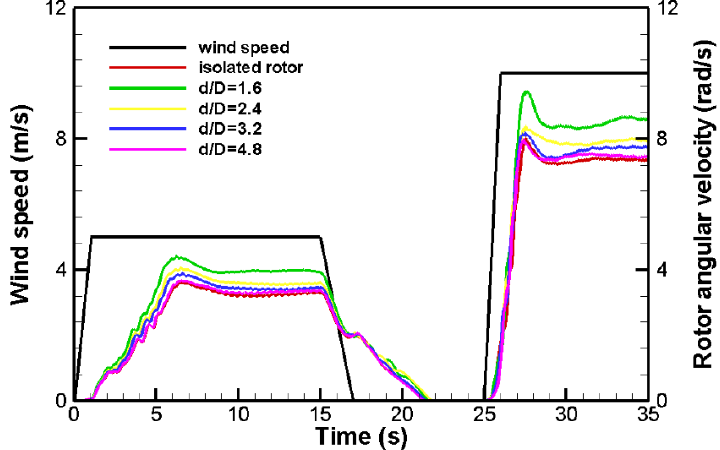
Figure 11. Wind speed and the induced angular velocities of two closely-placed counter-rotating rotors at various spacing.